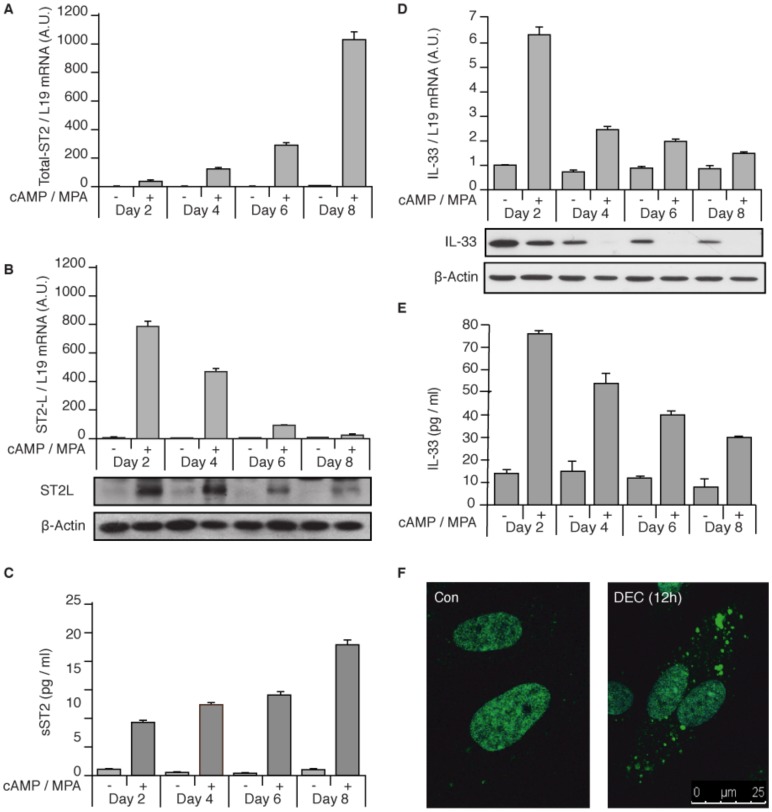
The IL-33/ST2L/sST2 axis in decidualizing HESCs.(A) Total ST2 transcript levels were measured in primary HESC cultures treated with 8-bromo-cAMP (cAMP) and MPA for the indicated time-points. (B) ST2L mRNA levels, expressed in arbitrary units (A.U.), were determined in primary cultures decidualized for 2–8 days (upper panel). Total cell lysates from parallel cultures were probed for ST2L expression (lower panel). β-actin served as a loading control. (C) The culture supernatant was harvested every 48 h and the levels of accumulated sST2 determined by ELISA. (D) Induction and release of IL-33 in decidualizing cells. Il-33 mRNA and protein was readily detectable in undifferentiated HESCs. IL-33 mRNA levels increased rapidly in response to cAMP and MPA (upper panel) but total cellular protein levels gradually declined upon decidualization (lower panel). (E) Il-33 rapidly accumulated in culture supernatant in response to cAMP and MPA signalling (F) HESCs cultured on chamber slides were decidualized for 12 h and stained for IL-33 expression (green). The nuclei were visualized with DAPI (not shown). The overlayed images were captured by confocal microscopy. Scale bar: 25 µm. Quantitative data represent the mean (± SD) of biologically triplicate experiments.